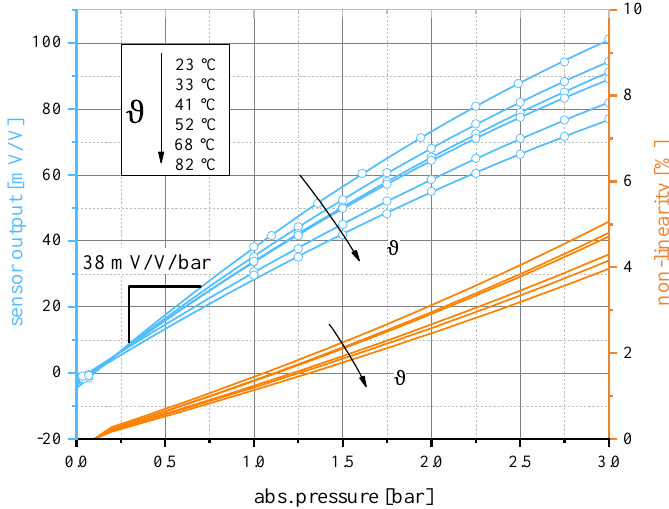
Figure 9. Exemplary pressure sensor calibration curves: sensor output (blue) depending on the ambient temperature. Blue lines represent polynomial (second order) least squares fitting to the data points. Linearity errors (orange) are calculated as the deviation of the polynomial fit from the linear fit in the corresponding interval.